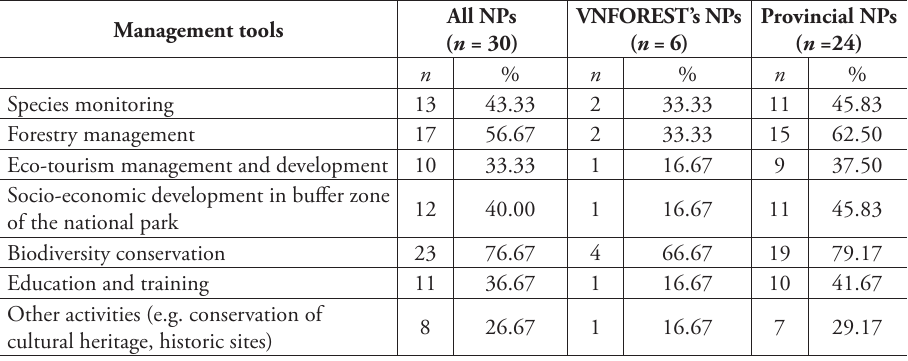
Table 9. Percentages of national parks reporting collaborations with different